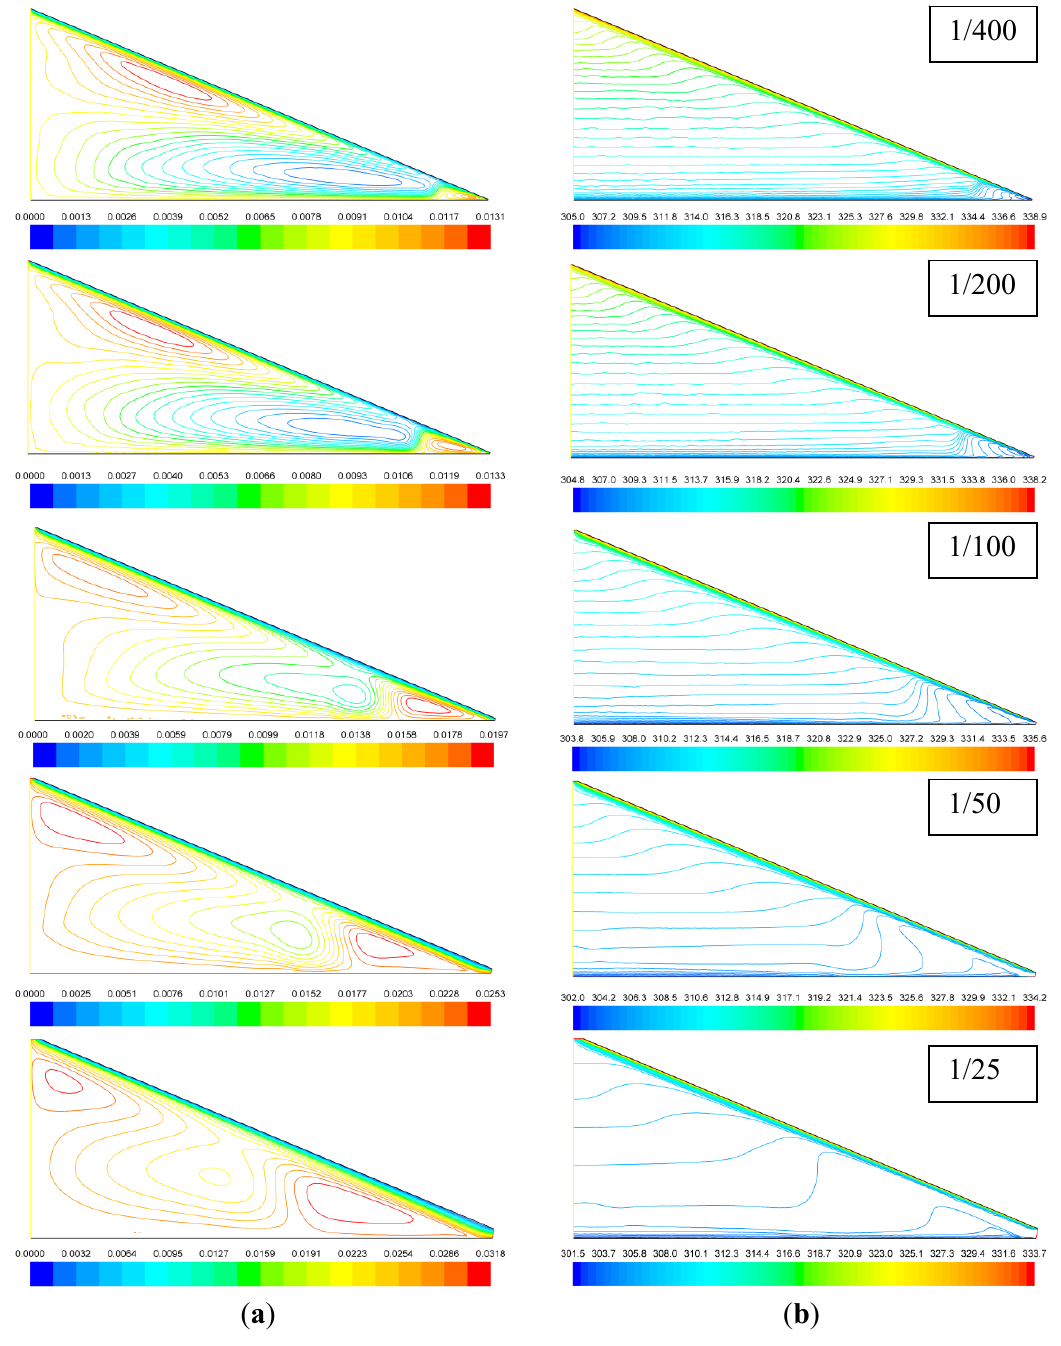
Figure 3. Predicted ( a ) streamlines (in kg/m s) and ( b ) isotherms (in K) for attics with balanced ridge and soffit vents at various ventilation